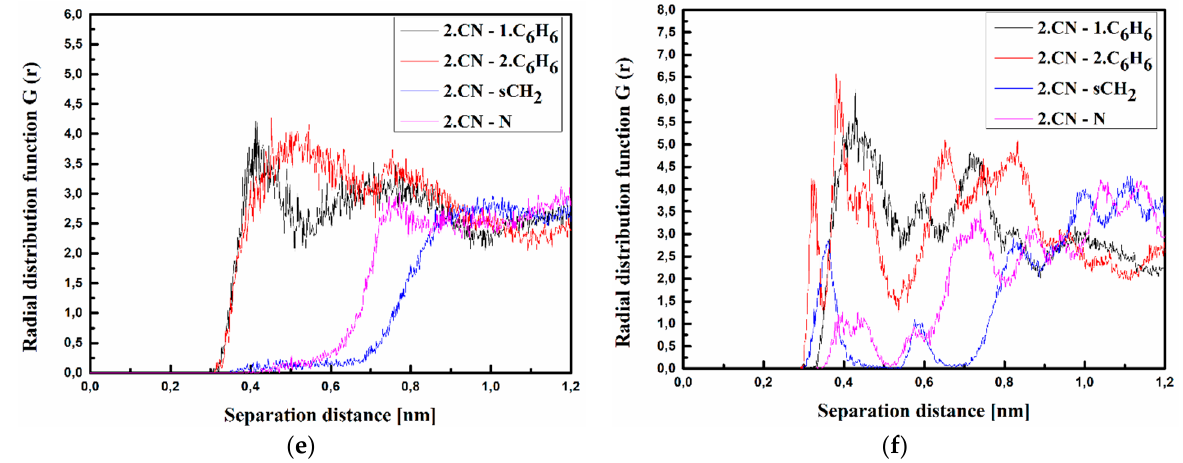
Figure 7. Partial RDFs calculated for distances between the center of mass of different moieties of the B molecule and different subunits of PVK at T = 500 K ( a , c , e ) and T = 300 K ( b , d , f ) for the thin-film system. The RDFs are presented for benzofuran group of B molecule and different subunits of PVK mer ( a , b ); for cyanovinyl CN1 at the side of the molecule B and different subunits of PVK mer ( c , d ); and cyanovinyl CN2 at the back of the molecule B and different subunits of PVK mer ( e , f ).